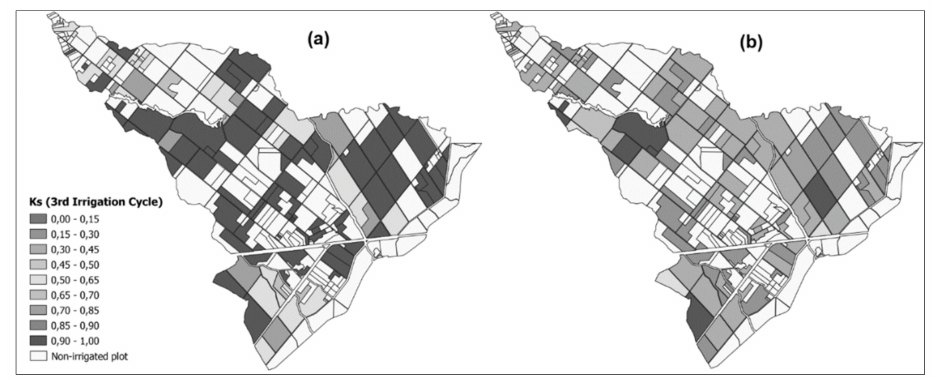
Figure 8. Stress coefficient (Ks) map of the first sowing scenario ( a ) and the sixth sowing scenario ( b ) at the beginning of the third irrigation